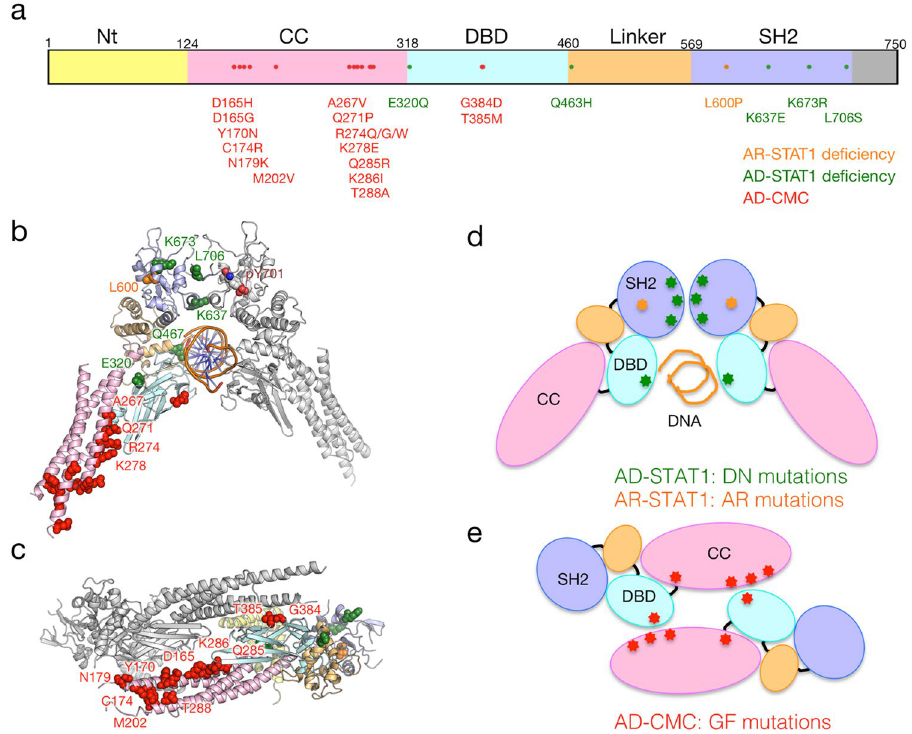
Figure 4. Locational distribution of mutation sites on STAT1 protein. ( a ) The schematic primary structure of STAT1 with structural domains and pathogenic missense mutations. ( b,c ) The mutations associated with different inheritance modes are colored differently. Mappings of the mutations on the crystal structures are shown for the parallel dimer ( b ) PDB code: 1bg1) and anti-parallel dimer ( c ) PDB code: 1yvl). The domains are colored according to panel a. The mutant residues are represented by sphere models. ( d,e ) The schematic models of the parallel dimer ( d ) and anti-parallel dimer ( e ) with the pathogenic mutations with phenotypes. The mutation associated with AR-STAT1 deficiency (colored orange) was buried in the SH2